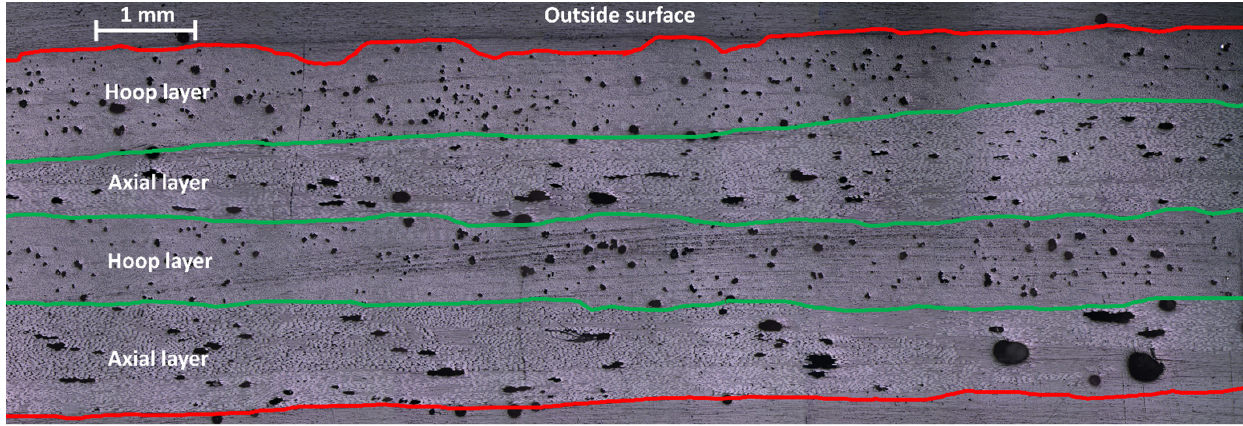
Figure 18. Hoop strain curves from the regions in Figure 17 for different cycles.